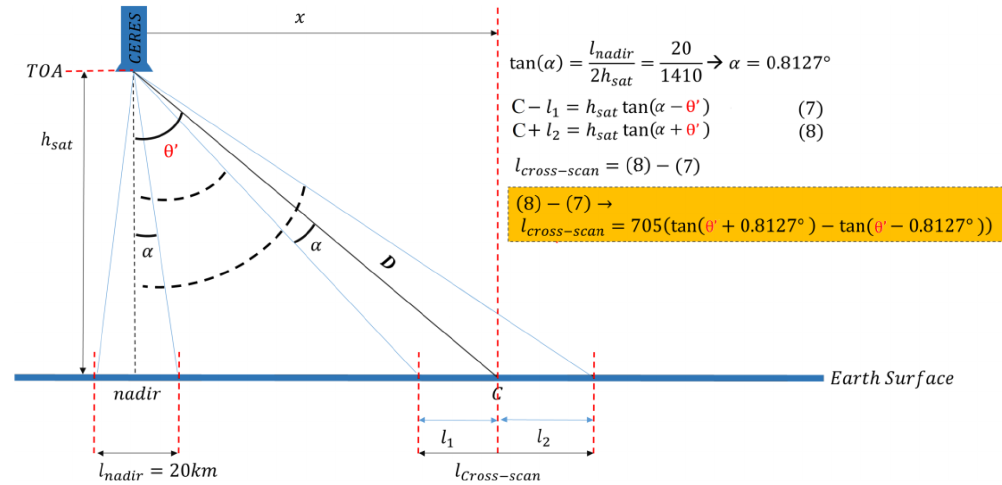
Figure A2. Geometry for Eq. (A2). Point C in this figure indicates the longitude at the center of the CERES footprint.